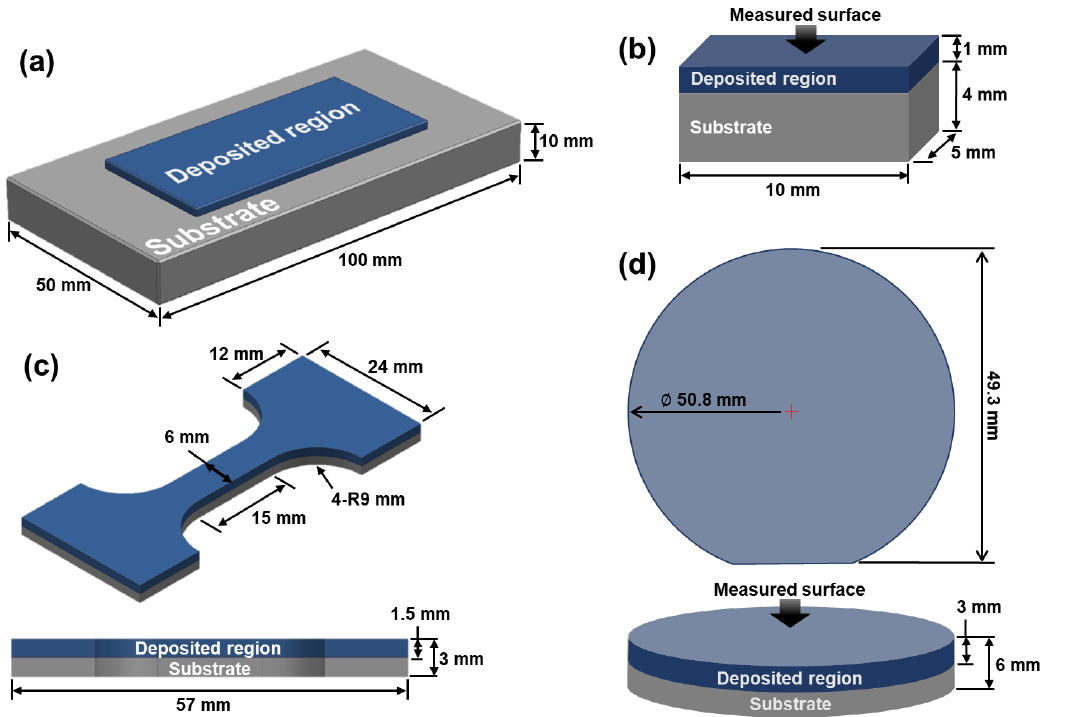
Figure 4. ( a ) Schematic of HTCS-150 locally deposited on H13 substrate. ( b – d ) Schematics of test specimens for hardness, tensile, and wear, respectively.